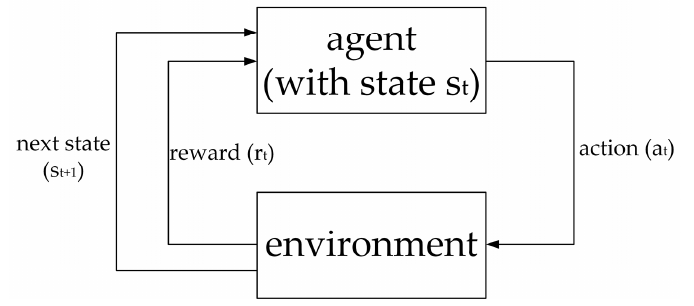
Figure 3. Schematic diagram of Qlearning.